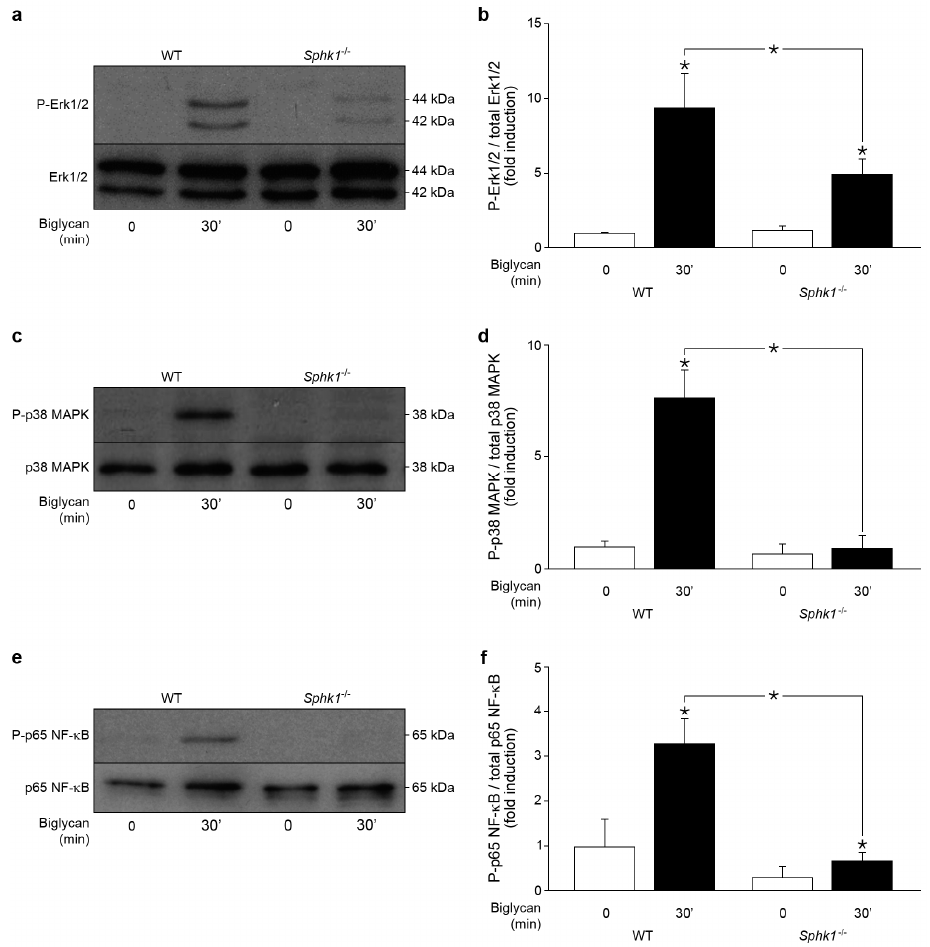
Figure 5. Biglycan phosphorylates Erk1/2, p38 MAPK and NF- κ B p65 in SphK1-dependent manner in macrophages. ( a , c , e ) Western blot analysis of: ( a ) Erk1/2 phosphorylation; ( c ) p38 MAPK phosphorylation; and ( e ) NF- κ B p65 phosphorylation in WT and Sphk1 − / − macrophages stimulated with biglycan (4 μ g/mL, 30 min). ( b , d , f ) Quantification of the resulting bands in ( a , c , e ), respectively, normalized to: ( a ) total Erk; ( c ) total p38; and ( e ) total p65. Data are expressed as means ± SD. n = 3 individual experiments; * p < 0.05.